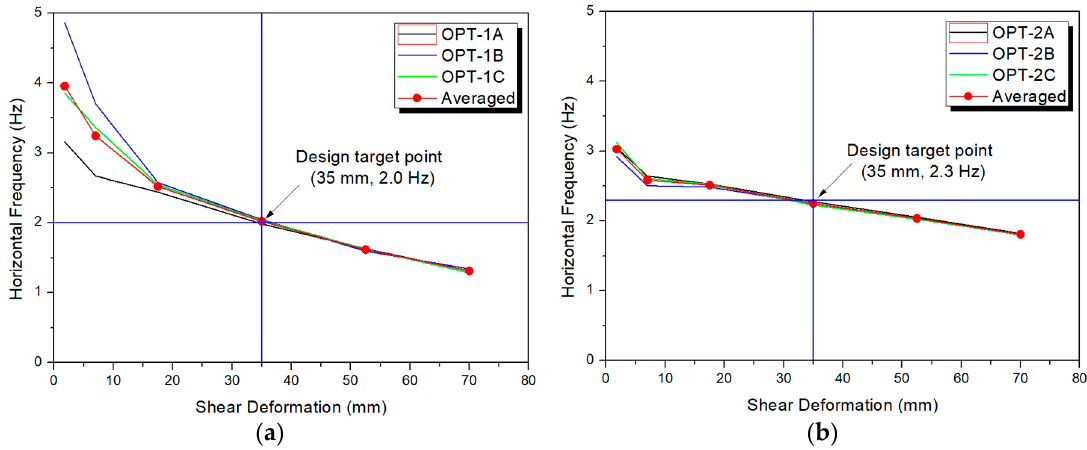
Figure 18. Determined horizontal seismic isolation frequency: ( a ) OPT-1; ( b ) OPT-2.